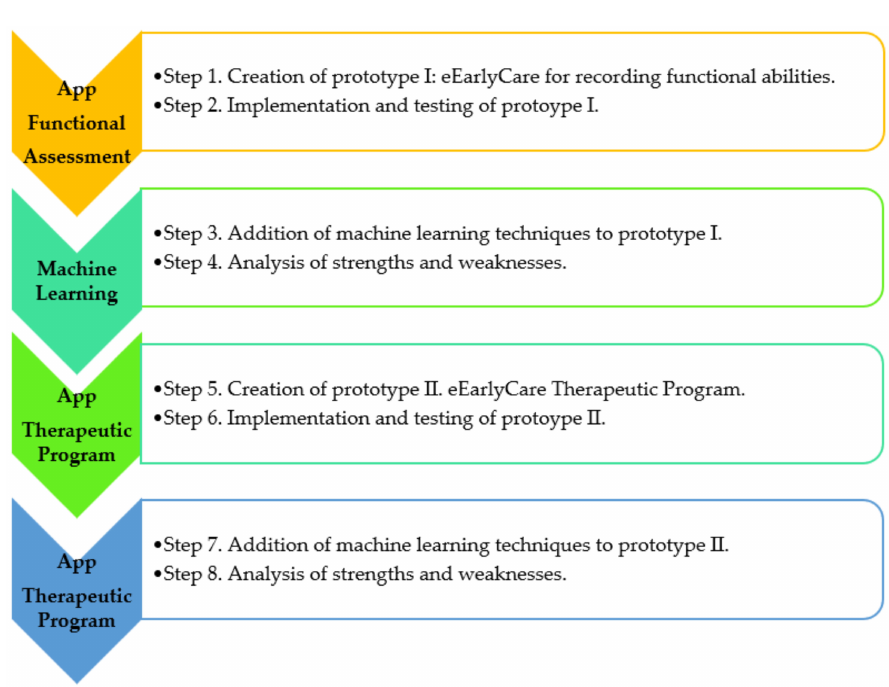
Figure 5. Functional and data requirements guiding the development of the eEarlyCare-T web application. Note. The results of the step 1 to 4 can be found in the publications